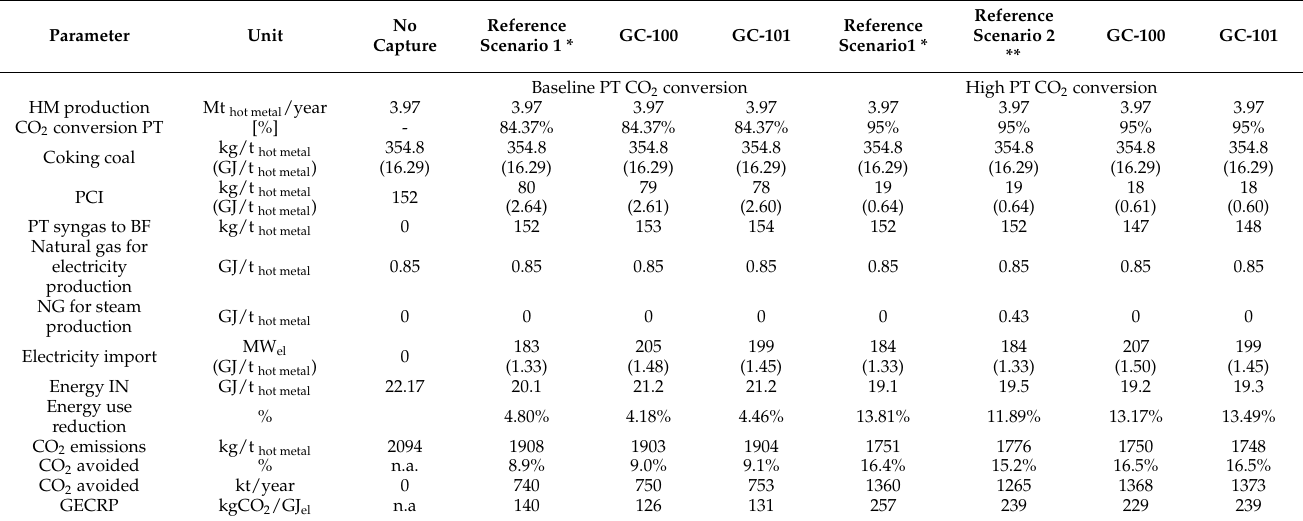
Table 8. Comparative modelling results for the reference case and the case integrating the novel membrane technology.